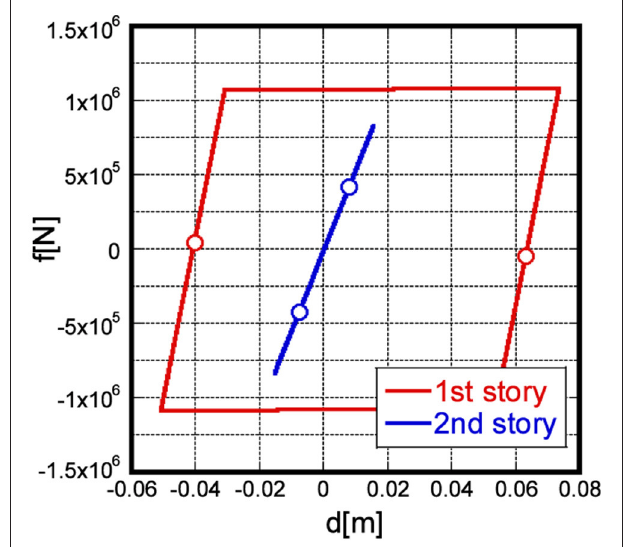
FIGURE 11 | Restoring force-interstory drift of model (a) under multiple impulse with V = 0.3[m / sec ] and t 0 = 0.910[ sec ] maximizing d p 1 .